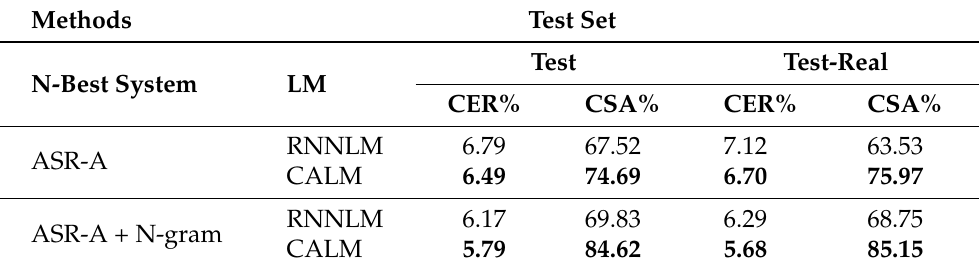
Table 3. The rescoring results with LM (English